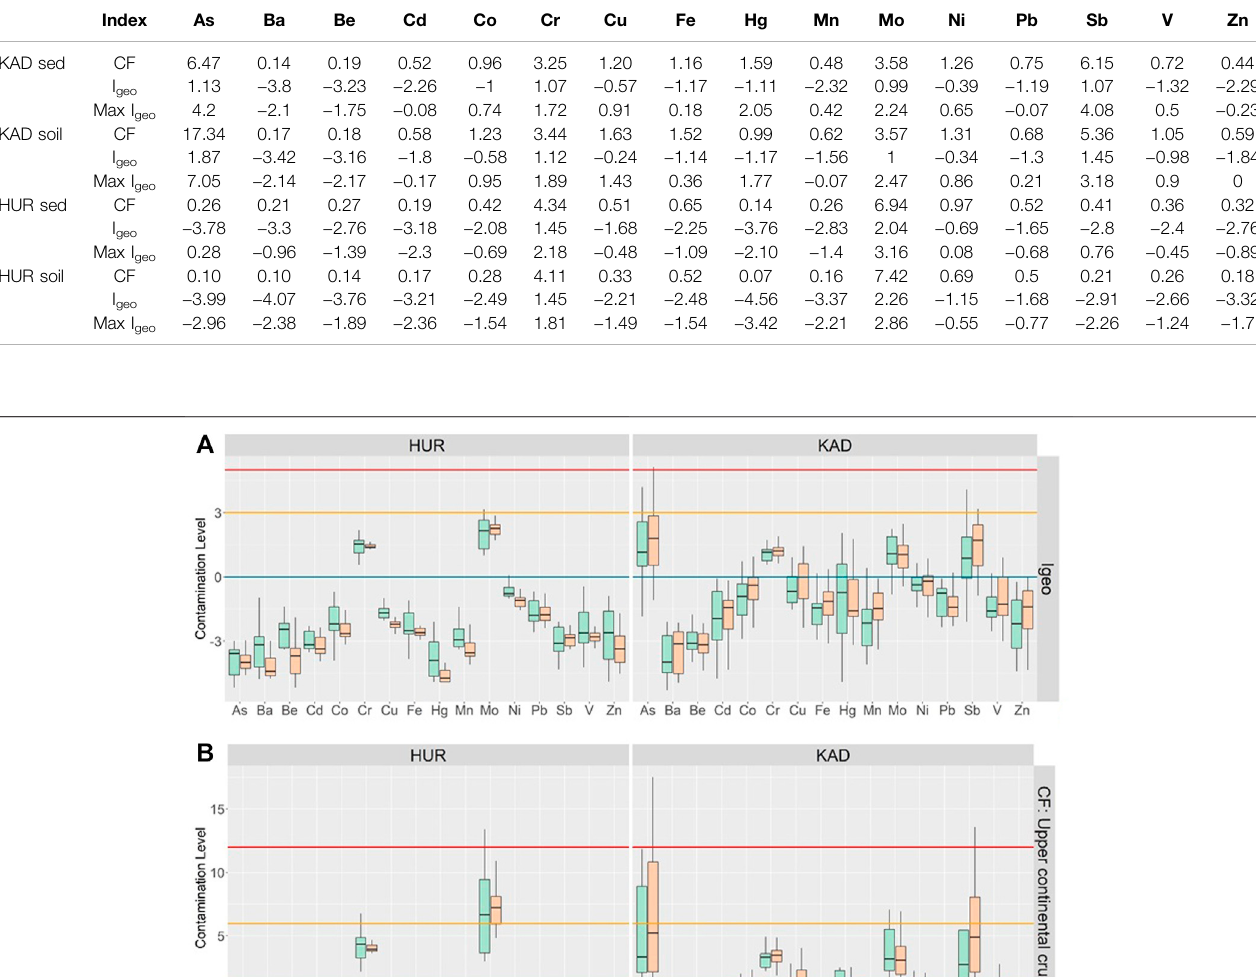
TABLE 5 | Comparison of average CF and I geo values.